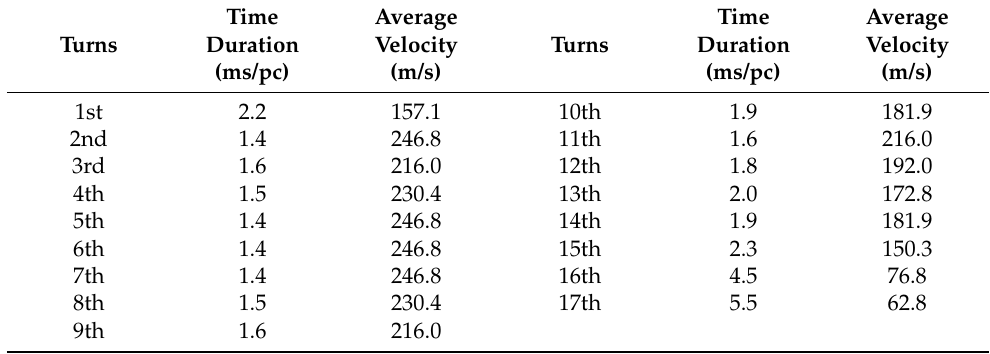
Table 5. Estimation of the averaged arc rotation velocity during the arcing process from calculation.